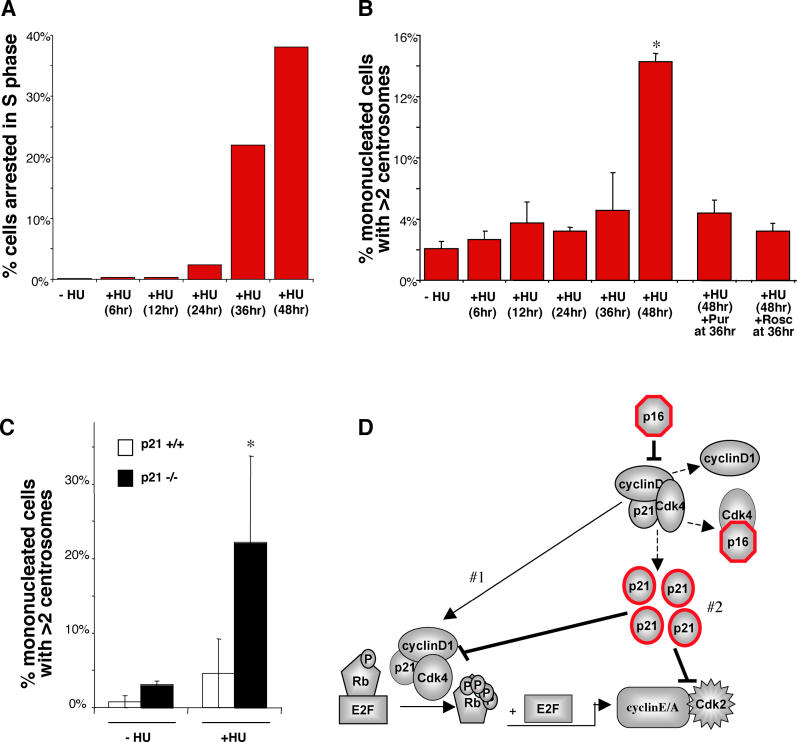
Unregulated Kinase Activity Is Responsible for the Uncoupling of the Centrosome Duplication and DNA Replication Cycles(A and B) vHMECs (RM9 [17 PD], RM16 [20 PD]) that were untreated (−HU) or treated for 6, 12, 24, 36, and 48 h with HU (+HU) were analyzed by (A) flow cytometry of PI and BrdU incorporation (% cells arrested in S phase) and (B) confocal microscopy for mononucleated cells with more than two centrosomes. The kinase inhibitors purvalanol A (Pur) and roscovitine (Rosc) were added following the addition of HU for 36 h and incubated in the presence of HU for 12 h (B).(C) Fibroblasts that express p21 (p21+/+) and that have p21 knocked out (p21−/−) were analyzed by confocal microscopy for mononucleated cells with more than two centrosomes. Centrosome number was determined by immunocytochemistry with an antibody recognizing the centrosome associated γ-tubulin protein. Centrosome number analysis included at least 200 cells per sample (excluding binucleated cells). *Statistical significance (p < 0.005) based on comparison of −HU and +HU experiments.(D) Model of two mechanisms by which p16INK4a can mediate Cdk2 activity. The p16INK4a protein inhibits the G1 kinase activity of the cyclinD1-Cdk4 complex by binding to Cdk4 and preventing its association with cyclinD1, thereby preventing transcriptional activation of the Cdk2 binding partners cyclin E/A (Mechanism 1). The p21 kinase inhibitor is required for assembly of and stabilization of the cyclinD1-Cdk4 complex. In the presence of p16INK4a, the cyclinD1-Cdk4 complex is disrupted, causing p21 to be released. When p21 accumulates to a critical threshold, it can bind to and inhibit the late G1 and S phase kinase activity of the cylinE/A-Cdk2 complex (Mechanism 2).